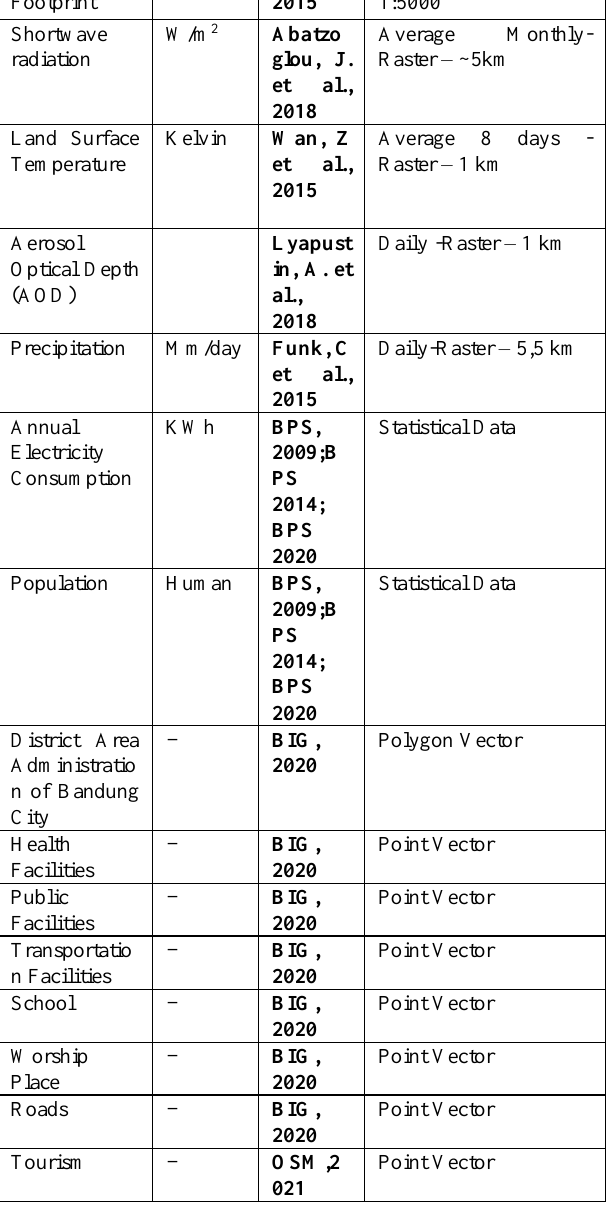
Table 1 Data used in this research 2.2